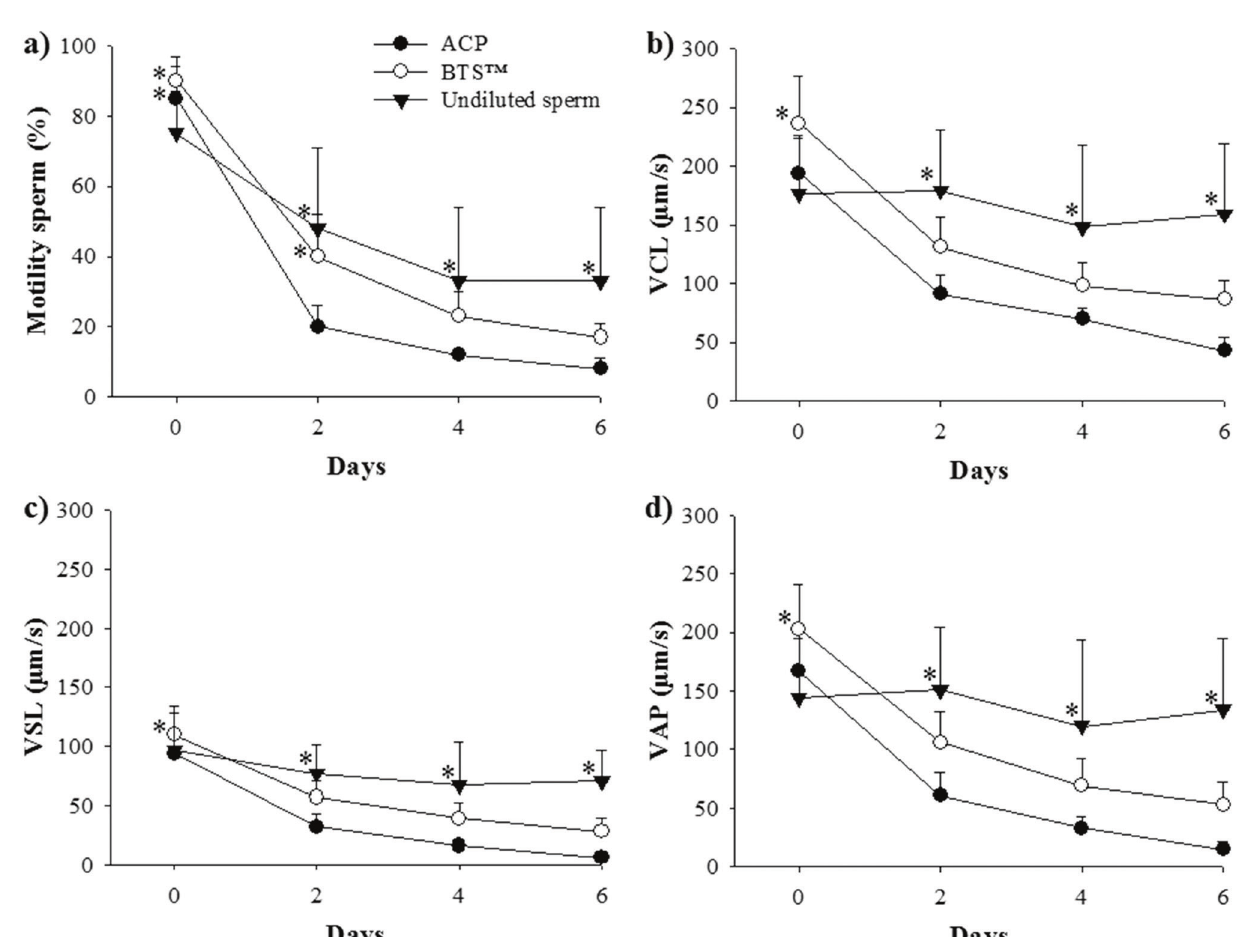
Fig. 1. Motility rate (a); curvilinear (VCL; b), straight-line (VSL; c) and average path (VAP; d) velocities of Prochilodus lineatus sperm diluted in two extender compositions (ACP = closed circles; BTS = open circles) and stored at 6-8°C for six days. Undiluted sperm served as control (closed triangle). Each dot and error bar represents mean ± SD; n=15 males. ACP: Powdered Coconut Water™; BTS: Beltsville Thawing Solution™. *Means followed by this symbol, within the same day of analysis, are significantly higher (P<0.05;